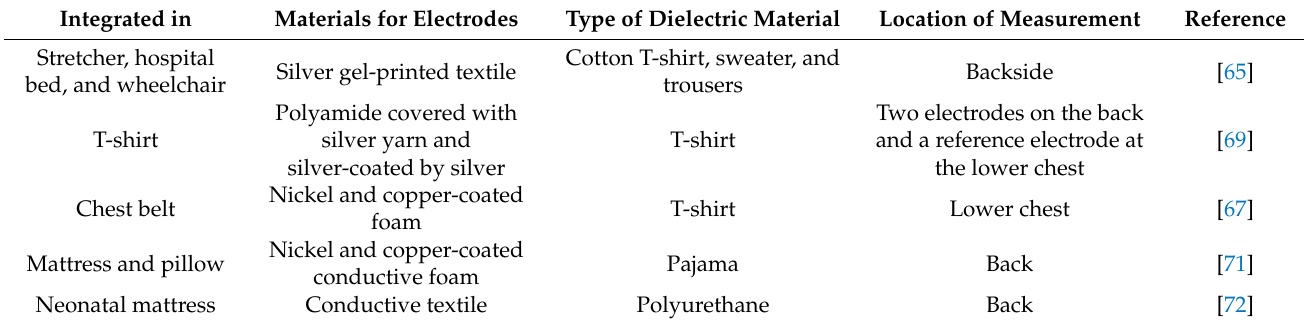
Table 1. Non-contact textile ECG